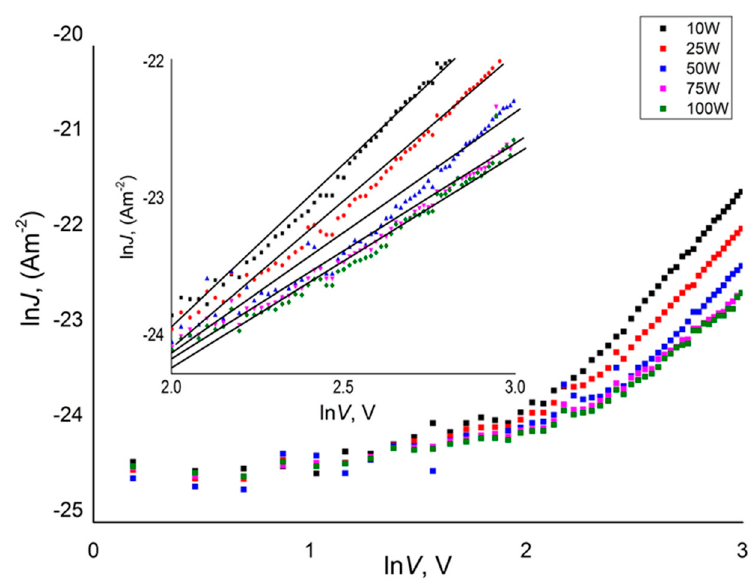
Figure 7. Variation of ln J with ln V for pelargonium plasma polymer thin films fabricated at different deposition powers. Table 2. Experimental β exp and theoretical β PF and β RS values of pelargonium plasma polymer films. Power of Deposition